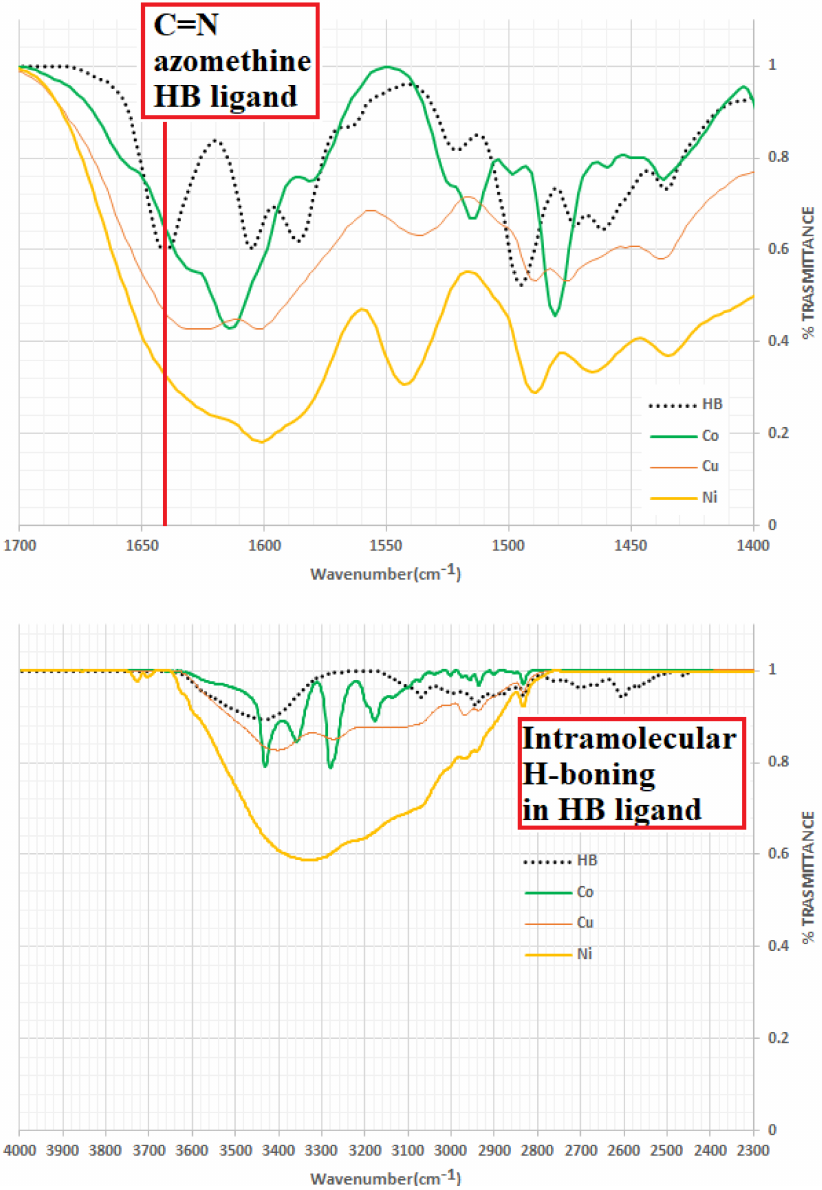
Figure 1. FTIR spectra of HB and its complexes with Cu, Co and Ni.